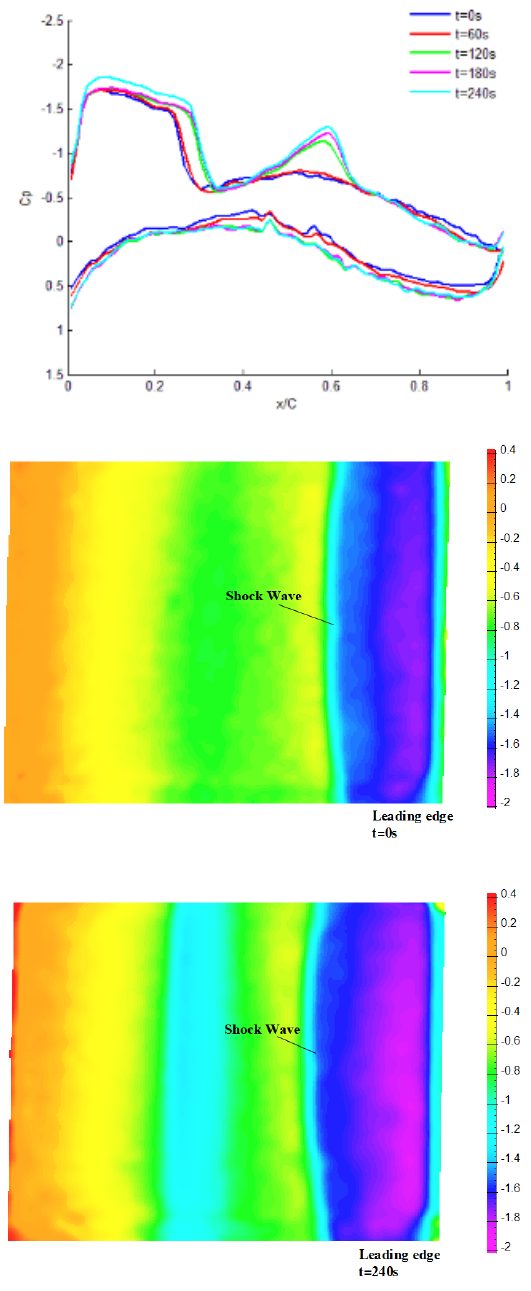
Figure 17. PSP measurement of surface pressure ( M =